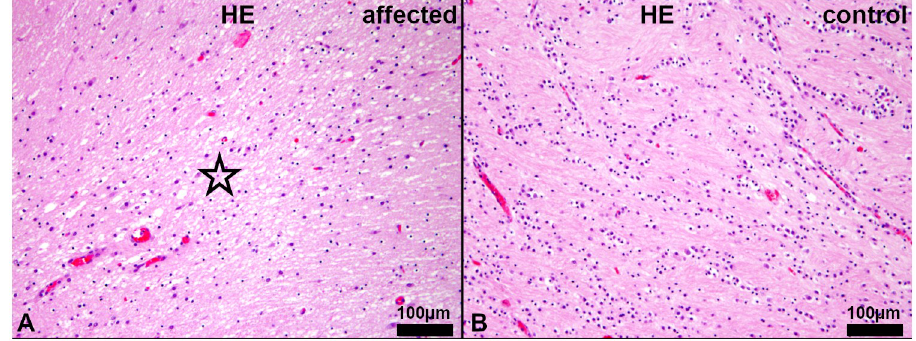
Fig 3. Histopathology of the centrum semiovale of the cerebrum. (A) Affected puppy no. 1 and (B) age matched healthy control no. 1009. (A) Reduced eosinophilia and moderate, diffuse edema of the white matter (asterisk) of affected puppy. (HE). (B) Regular diffuse eosinophilia, indicating normal myelination, in the white matter of an age matched control puppy. (HE).